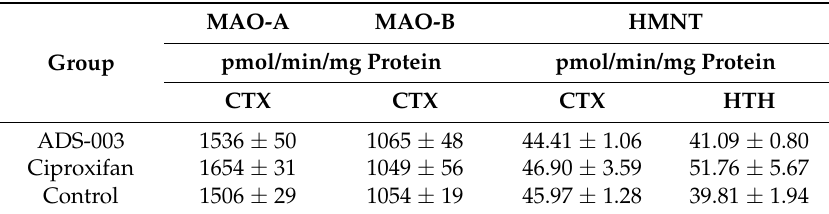
Table 2. The effect of subchronic administration of ADS-003 (s.c. 3 mg/kg/daily for 5 days) or